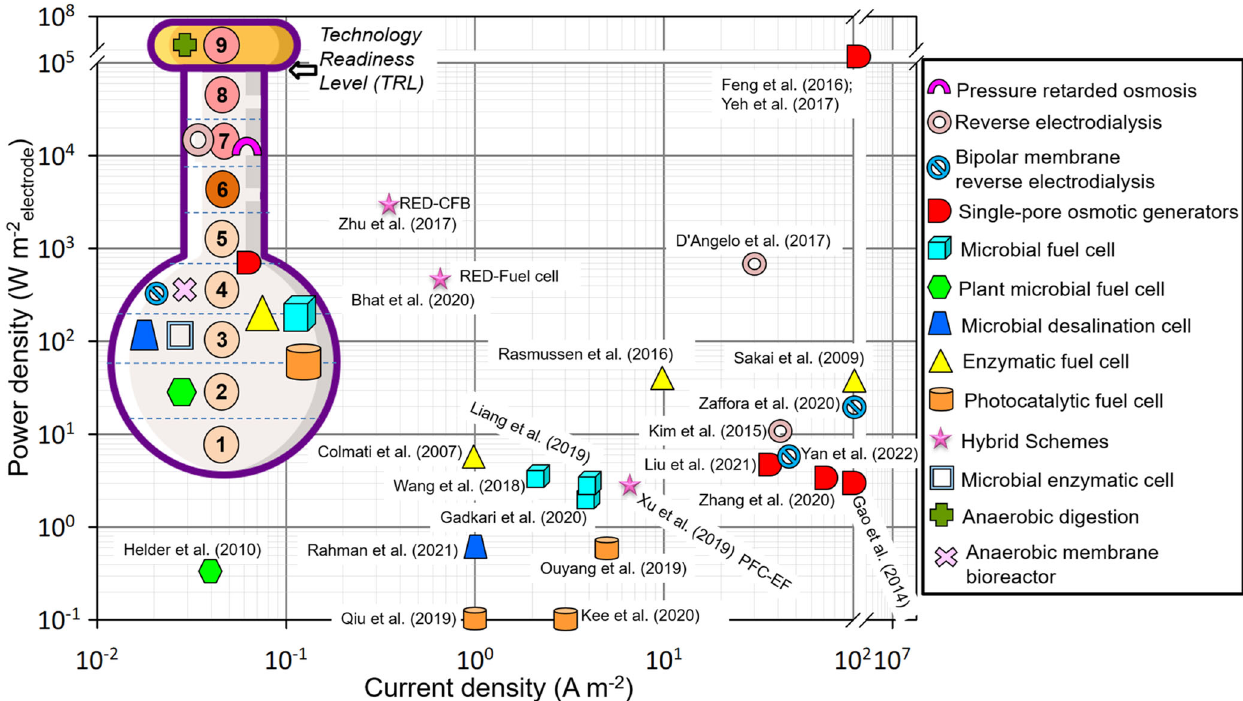
Fig. 5 Technology readiness level (TRL), power density, and current density of wastewater-based energy-generation techniques. Inset is the TRL scale from 1 to 9. CFB represents common fl ow battery, and EF represents electro-Fenton [Data were collected from refs. 44,48,49,78,89 – 107